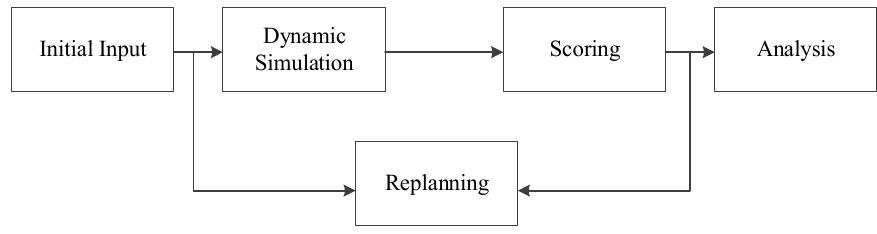
Figure 1. CCTSim (Citizen Commuting Transportation Simulation) loop.